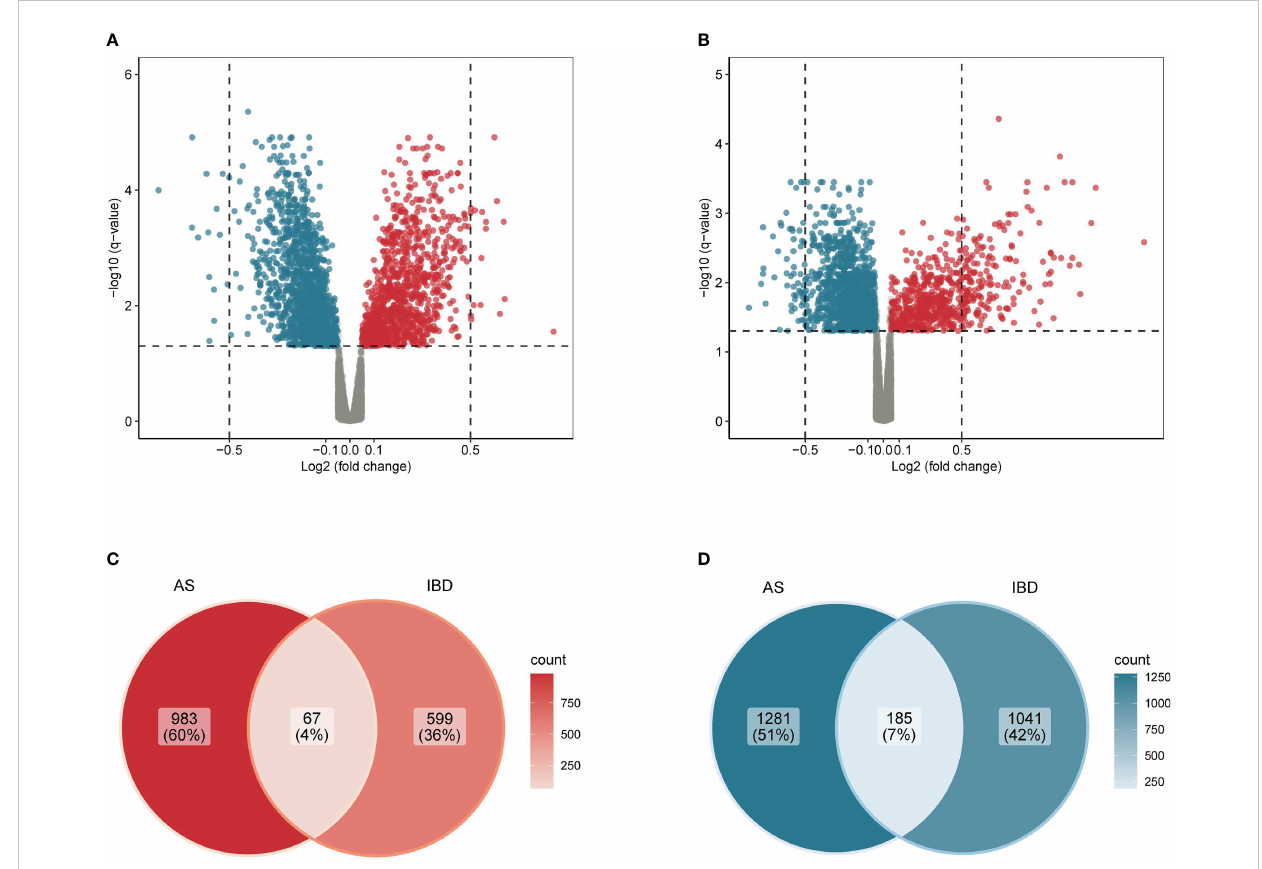
FIGURE 2 Common differentially expressed genes in AS and IBD (A) Volcano plot of differentially expressed genes in AS. (B) Volcano plot of differentially expressed genes in IBD. (C) Venn diagram of common up-regulated differentially expressed genes in AS and IBD. (D) Venn diagram of common down-regulated differentially expressed genes in AS and